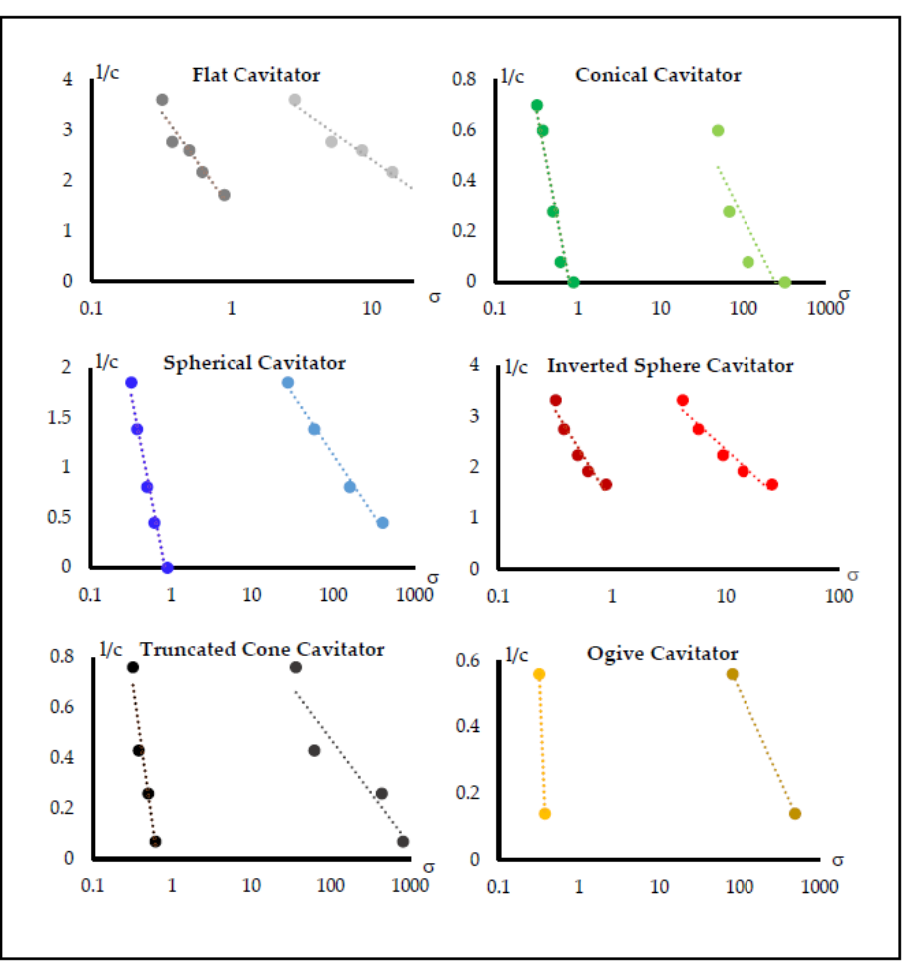
Figure 10. The bubble length (in terms of body diameter) for the six cavitators vs. the cavitation number calculated in two ways, using Equation (3) in dark colors on the left and Equation (5) in light colors on the right.